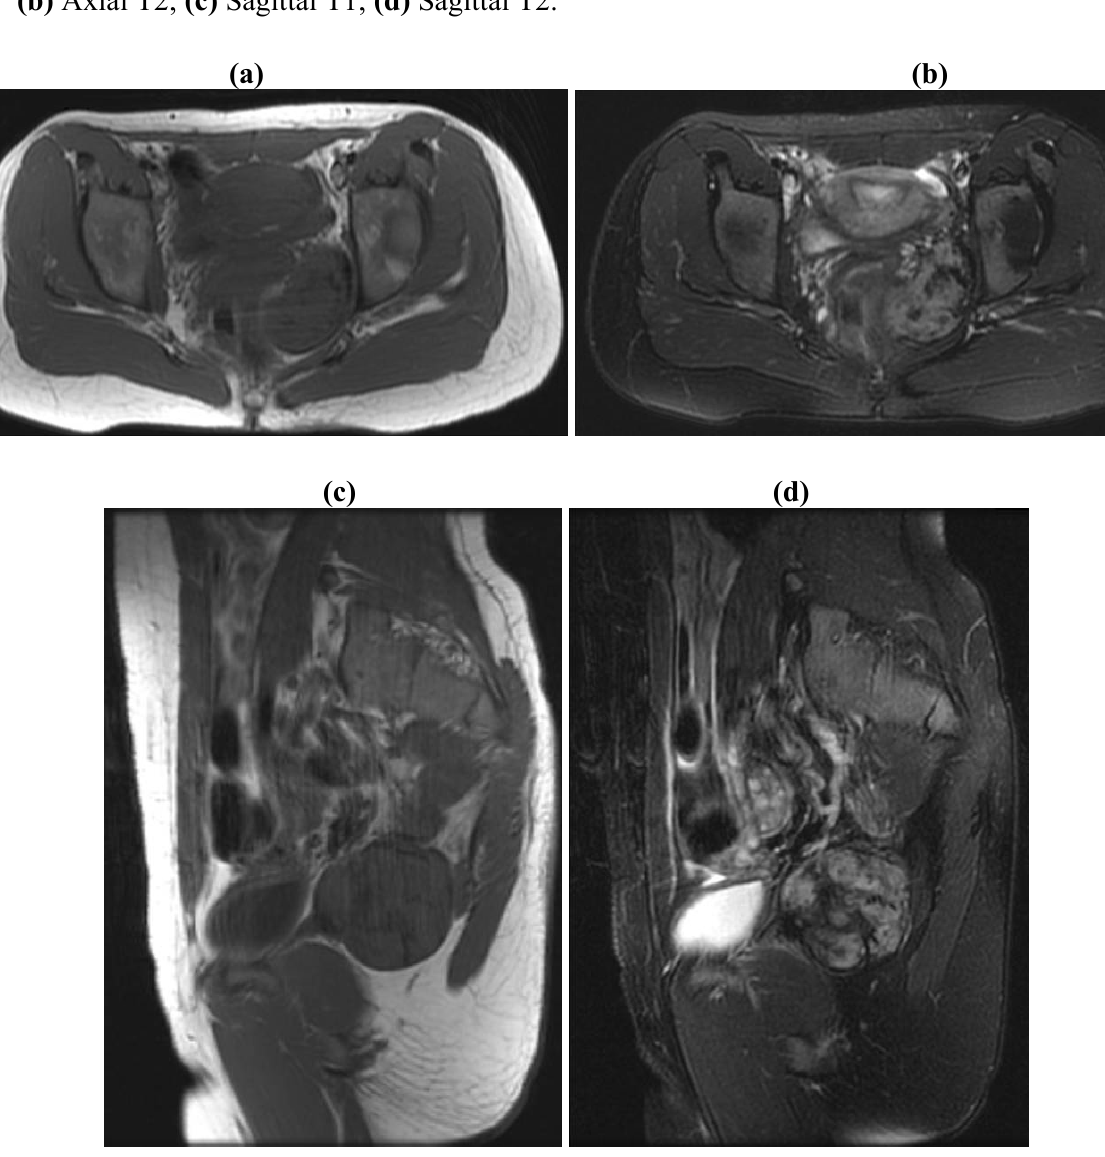
Figure 2. 31/F with deep pelvic desmoid with a history of FAP treated with excision utilizing a combined Pfannenstiel and ischiorectal approach. Adjuvant radiation was administered as a result of positive margins. MRI Findings: There is an 8.4 × 6.8 × 5.5 cm enhancing irregularly-shaped mass centered in the left ischiorectal fossa. There is full- thickness invasion of the left obturator internus muscle. The mass extends across the midline to the right with invasion of the perirectal muscles as well as posteriorly up to, and likely involving a small portion of the gluteus maximus muscle on the left. (a) Axial